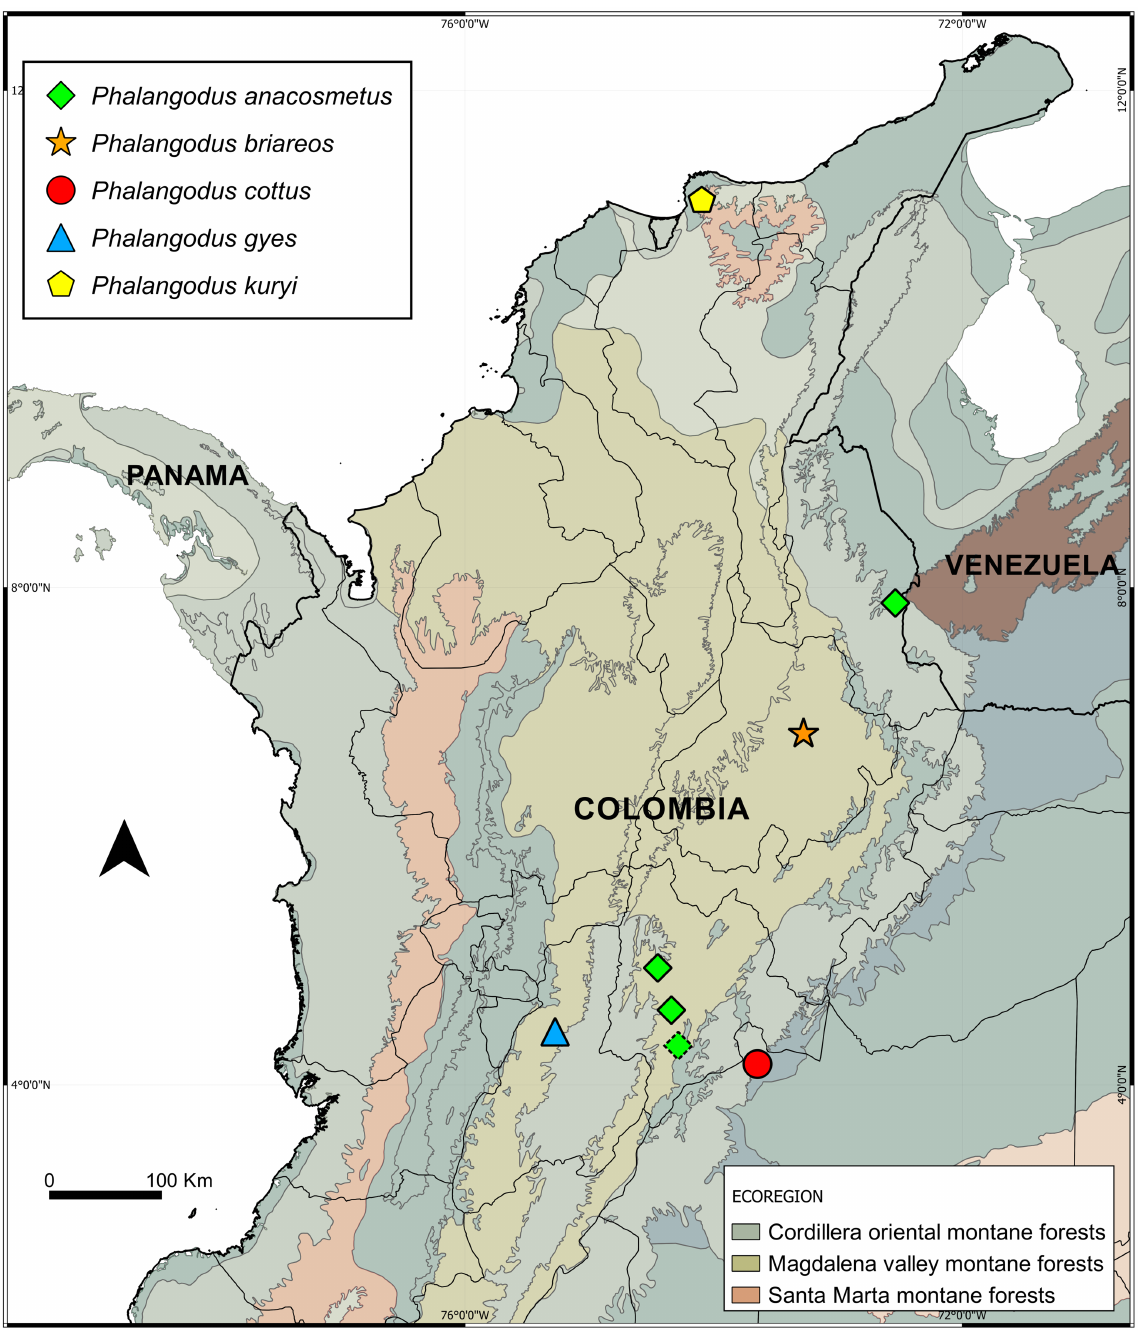
Fig. 18. Map of geographical records of Phalangodus spp. in Colombia (diamond with interrupted line corresponds to Boca del Monte